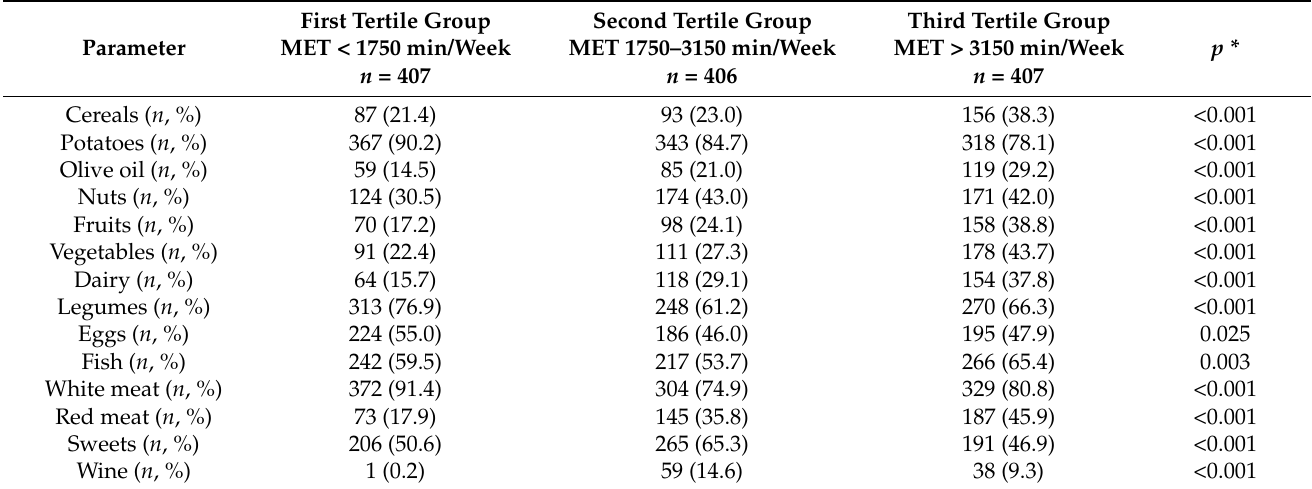
Figure 1. Histogram showing the MDSS score in the study sample ( n = 1220). Table 3. Differences in the adherence to the MDSS components between the tertiles of the IPAQ-SF